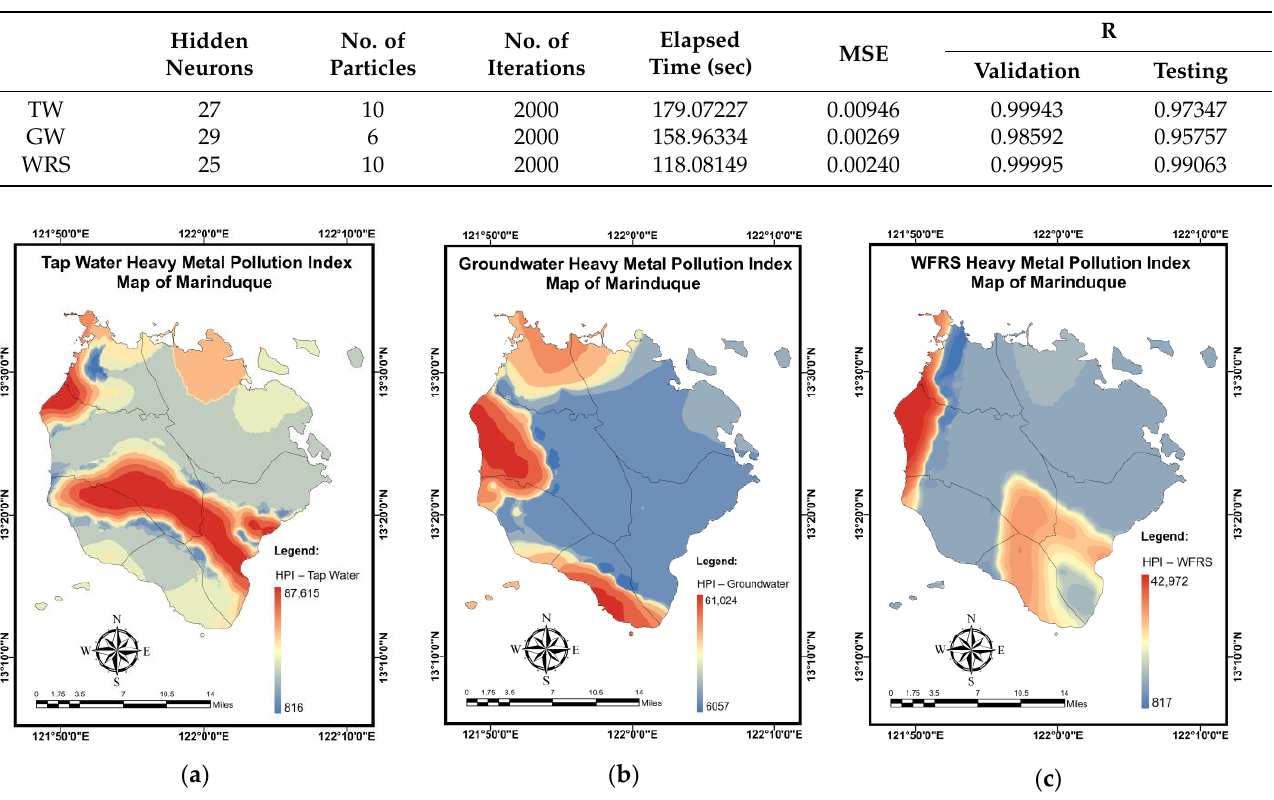
( c ) Figure 15. Spatial maps of NPI developed using MLGI approach for ( a ) TW samples, ( b ) GW sam- ples, and ( c ) WRS samples. The findings of a simulation for the HI (adults) mapping of domestic water samples using the NN-PSO approach with the EBK technique are shown in Table 13. The valida- tion and testing plots for the HI (adults) maps are illustrated in Figure A9 in Appendix B. As shown in Figure 16a, Brgy. Buangan, Torrijos reported the highest HI (adults) for tap water. As seen in Figure 16b, the highest HI (adults) values for GW were observed in Brgy. Bicas-Bicas, Municipality of Buenavista. Additionally, the highest HI (adults) for WRS was recorded in Brgy. Janagdong, Mogpog Municipality as shown in Figure 16c. Table 13. NN-PSO simulation results for the HI (adults) mapping of domestic water samples.